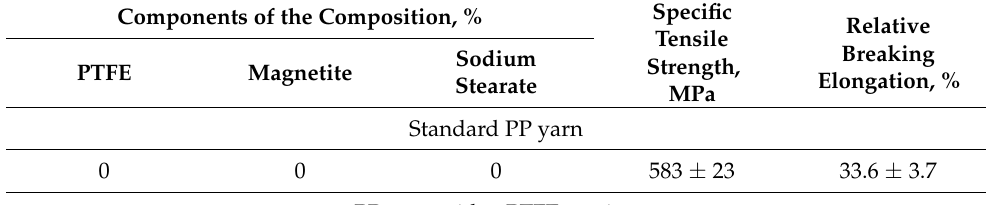
Table 1. Tensile strength and elongation of PP yarns with a PTFE coating doped with magnetite particles. Components of the Composition,